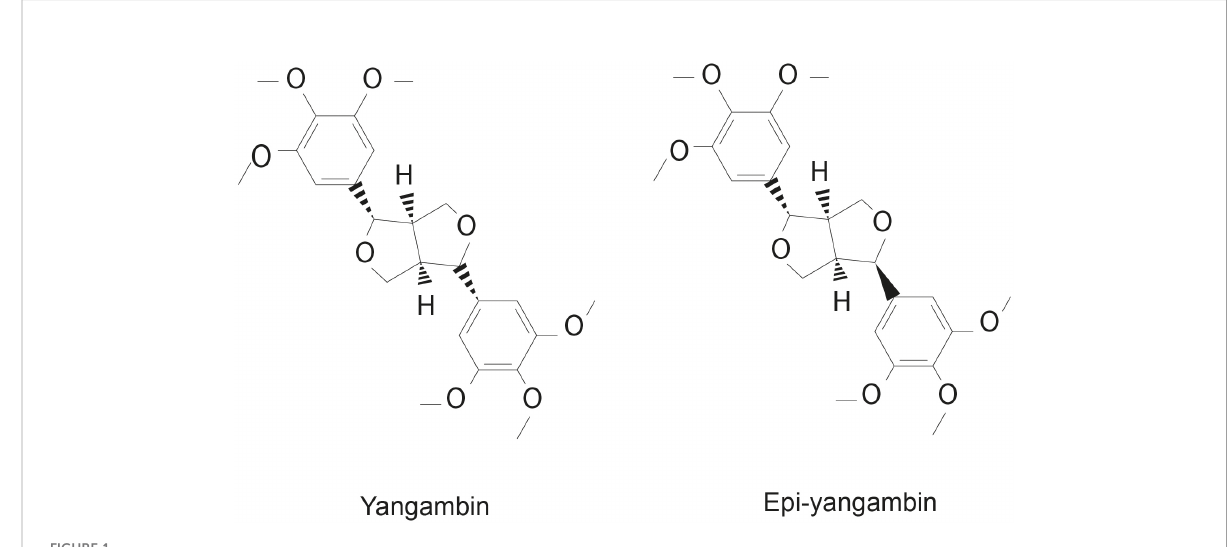
FIGURE 1 Chemical structures of yangambin and epi-yangambin